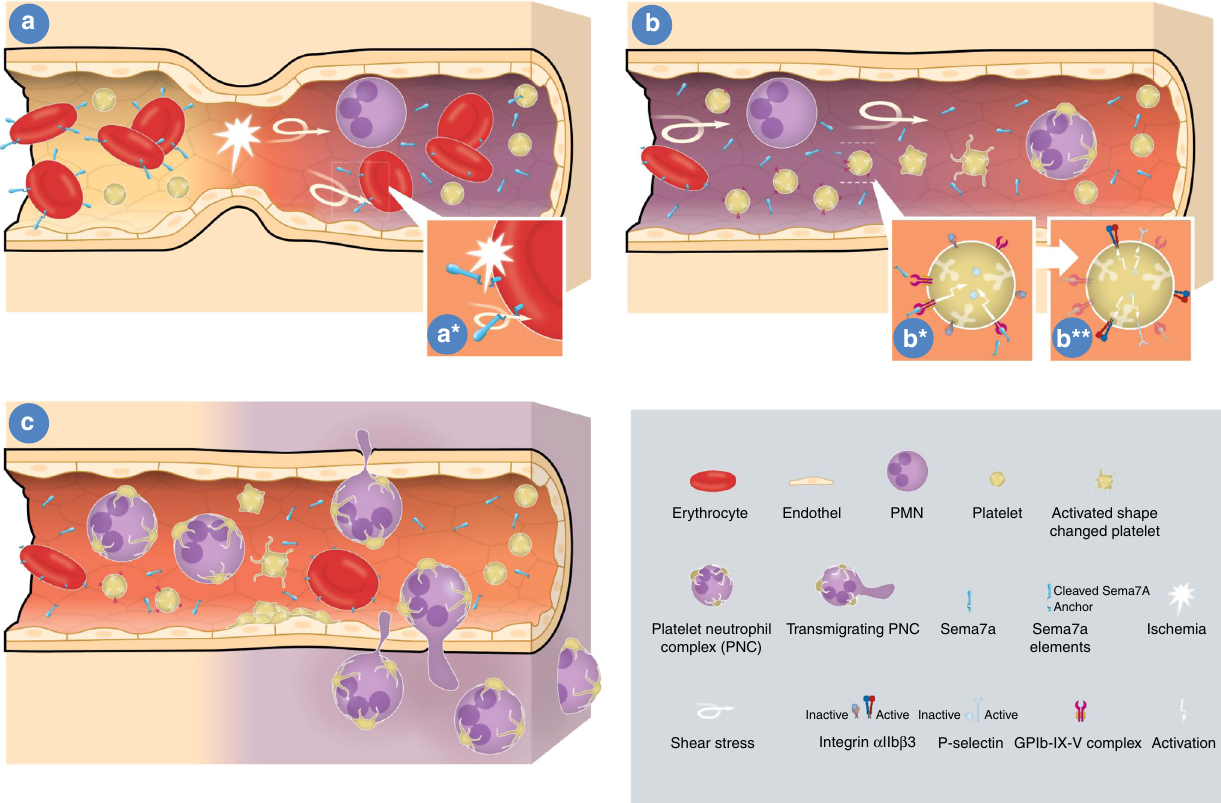
Fig. 7 Schematic drawing of the role of Sema7a during myocardial IR. a During myocardial ischemia shear stress and hypoxia result in cleavage of Sema7a from the surface of erythrocytes as the main source of Sema7a within the vascular bed. b The released Sema7a then engages the Glycoprotein Ib receptor and activates platelets which then exposes the integrin receptors resulting in platelet – neutrophil complex formation (PNCs). c Activated platelets and PNCs migrate from the vasculature to the ischemic tissue which results in tissue injury and